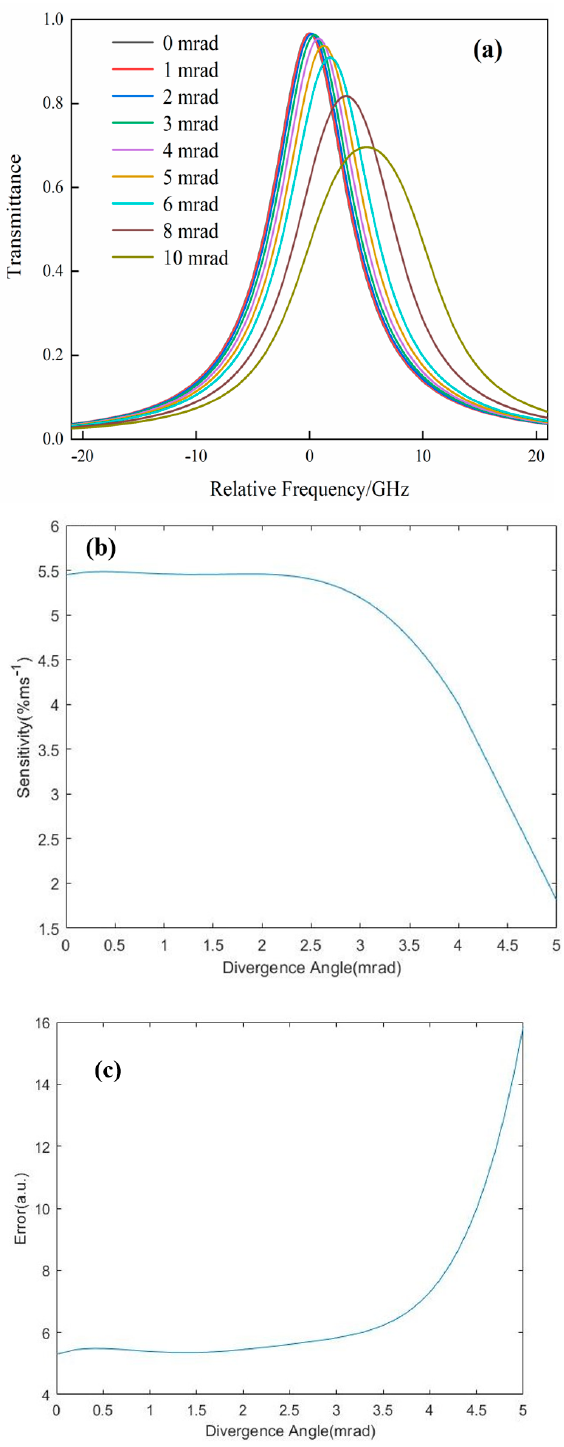
Figure 7. The effects of different incident light divergence angles on ( a ) transmittance curve ( b ) ve- locity sensitivity ( c ) wind speed measurement error.